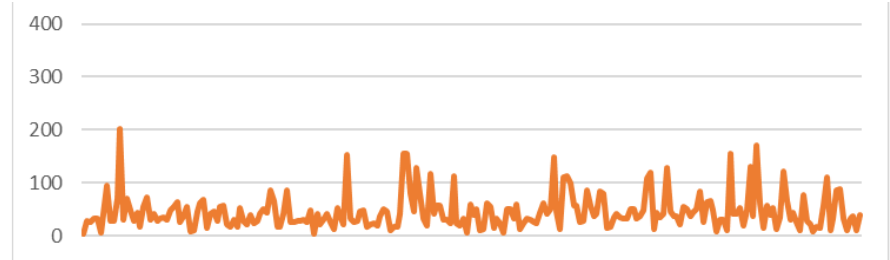
Figure 11. Time delay between detection and application exit (Δt12 vs . ms).